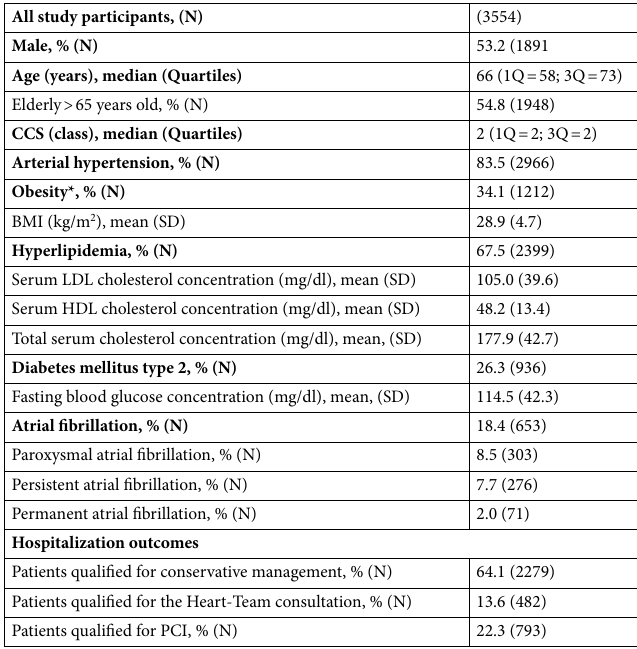
Table 1. Characteristics of the study participants. *Obesity was defined as body mass index > 30 kg m 2